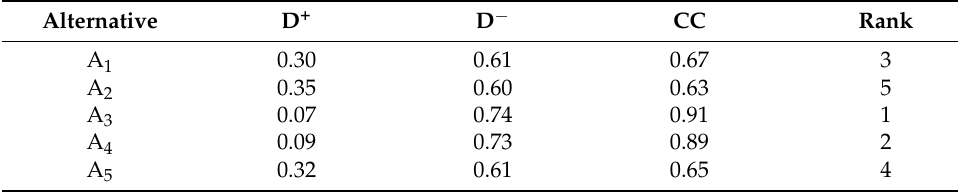
Table 10. CC for FTOPSIS and